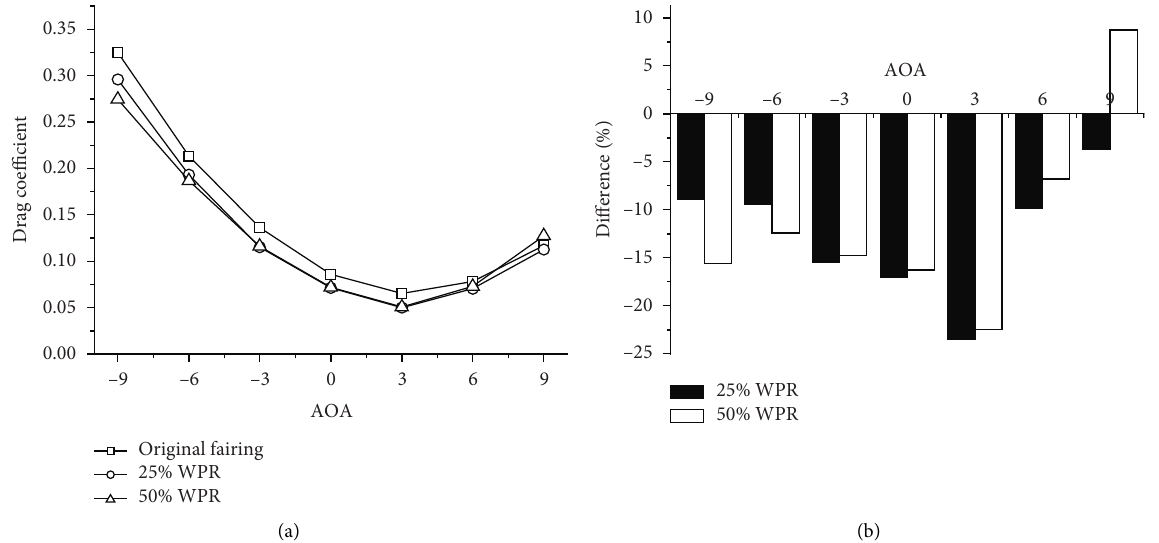
Figure 8: Static wind tunnel test results for C d (turbulent flow): (a) C d versus AOA; (b) difference (%) versus